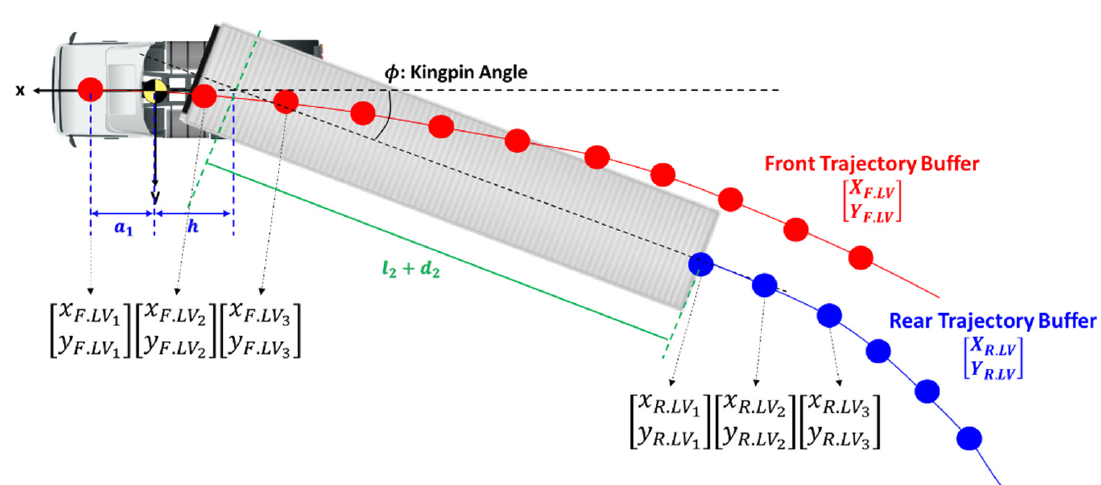
Figure 10. Subject vehicle trajectory buffer.